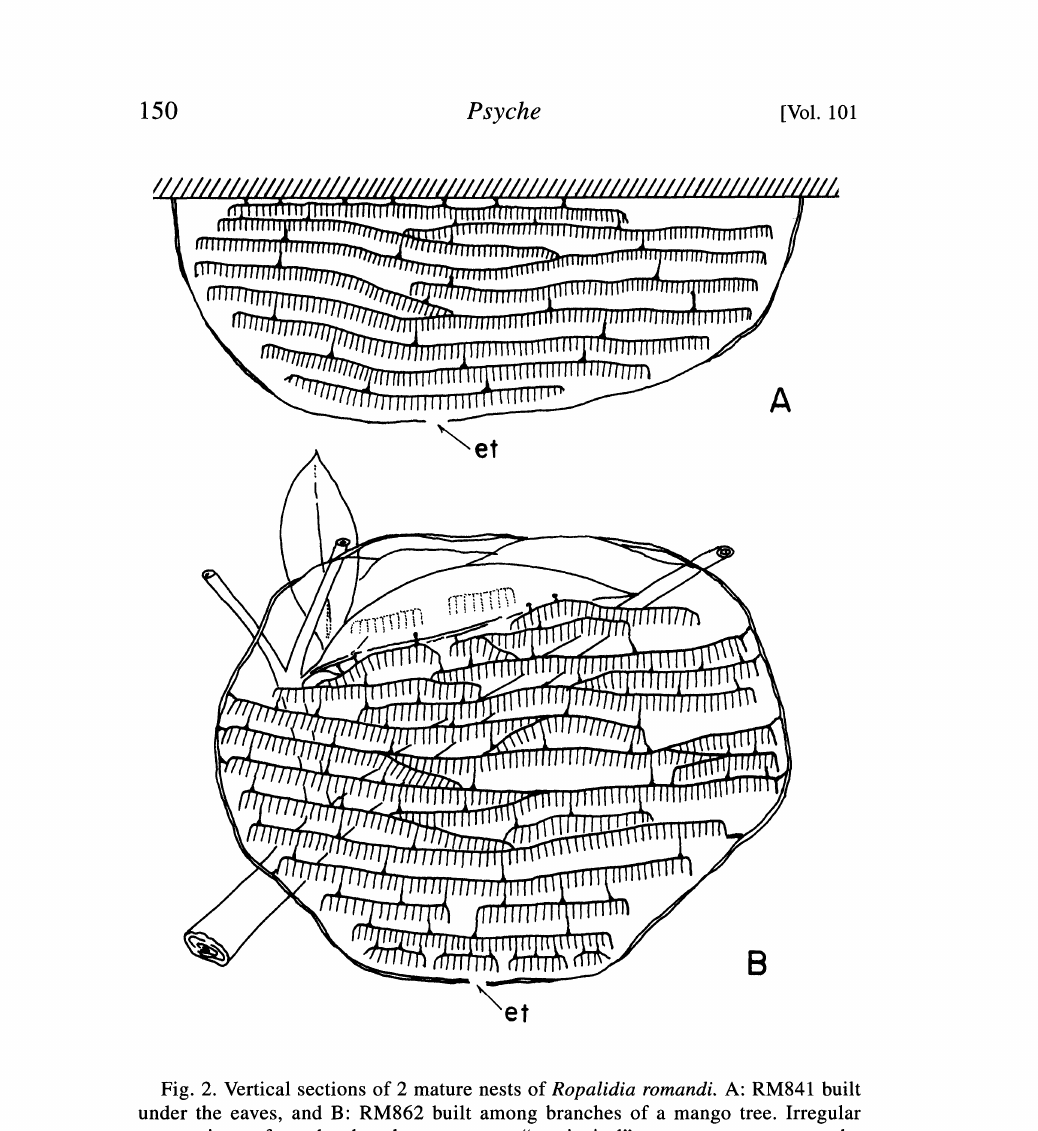
Fig. 2. Vertical sections of 2 mature nests of Ropalidia romandi. A: RM841 built under the eaves, and B: RM862 built among branches of a mango tree. Irregular connections of combs that demonstrate a "semispiral" structure are seen at the upper part. et: entrance